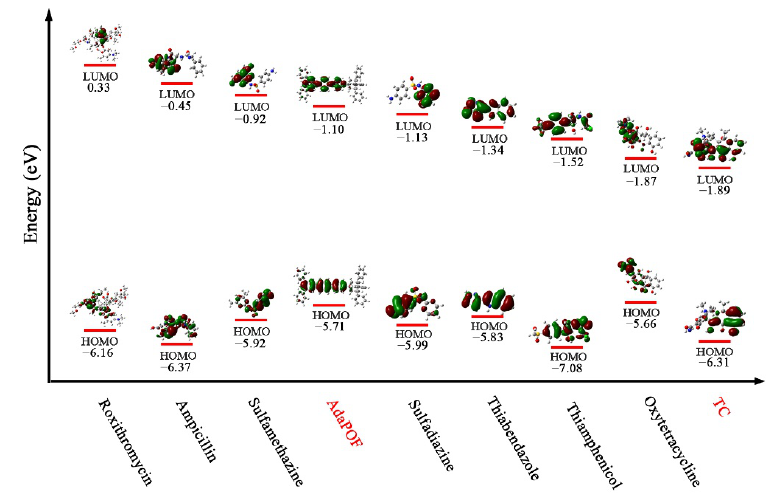
Figure 5. HOMO–LUMO energy profiles of AdaPOF and